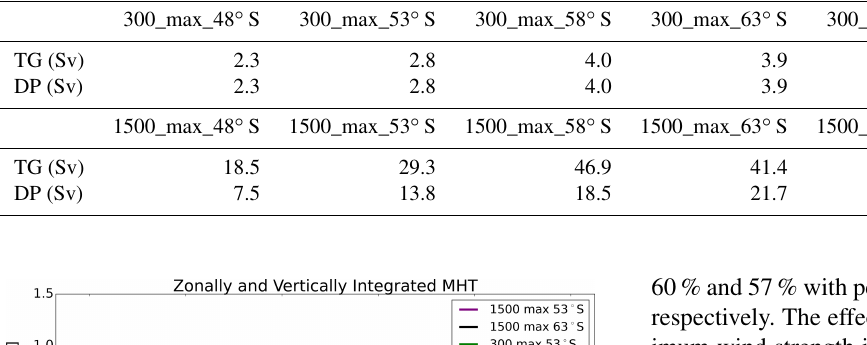
Table 2. Net TG and DP throughflow volume transport (Sv). Positive values indicate eastward transport, and negative values present westward transport. All values are the annual mean transport of the final 15 years of the simulations.